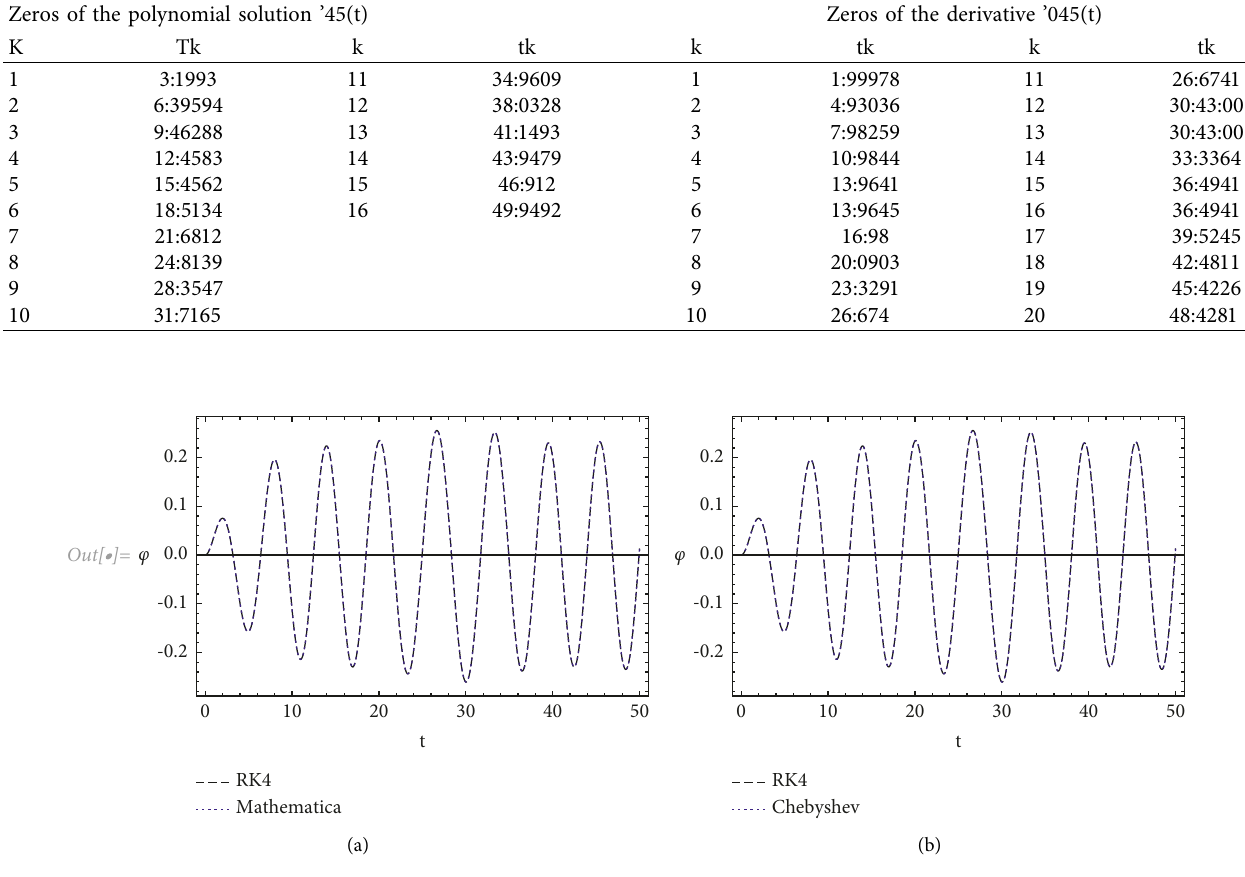
, φ , _ φ . 2 , 0 . 2 , 1 , 1 , 0 . 2 , 1 , 0 . 1 , 0 , 0 β , c , ω 0 , ω 2 , ε , 0 0 ) (cid:28) ( 0 ( Ω